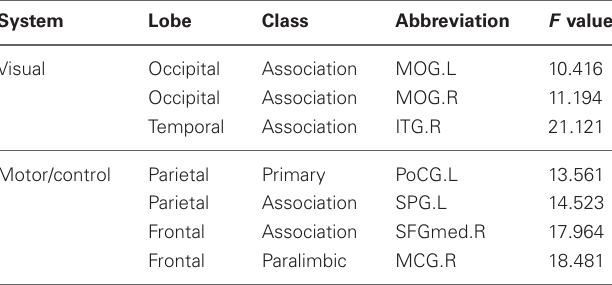
Table 2 | Significant negative linear correlation between the annual rate of change in node strength and the baseline